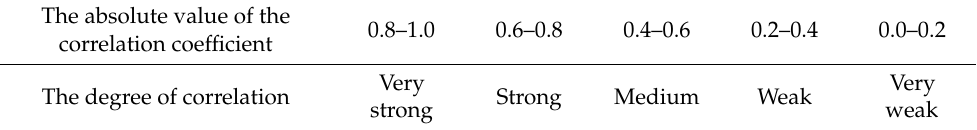
Figure 10. Scatter figure of ∆ V charge . Table 3. Judgment criteria between the degree of correlation and the correlation coefficient.